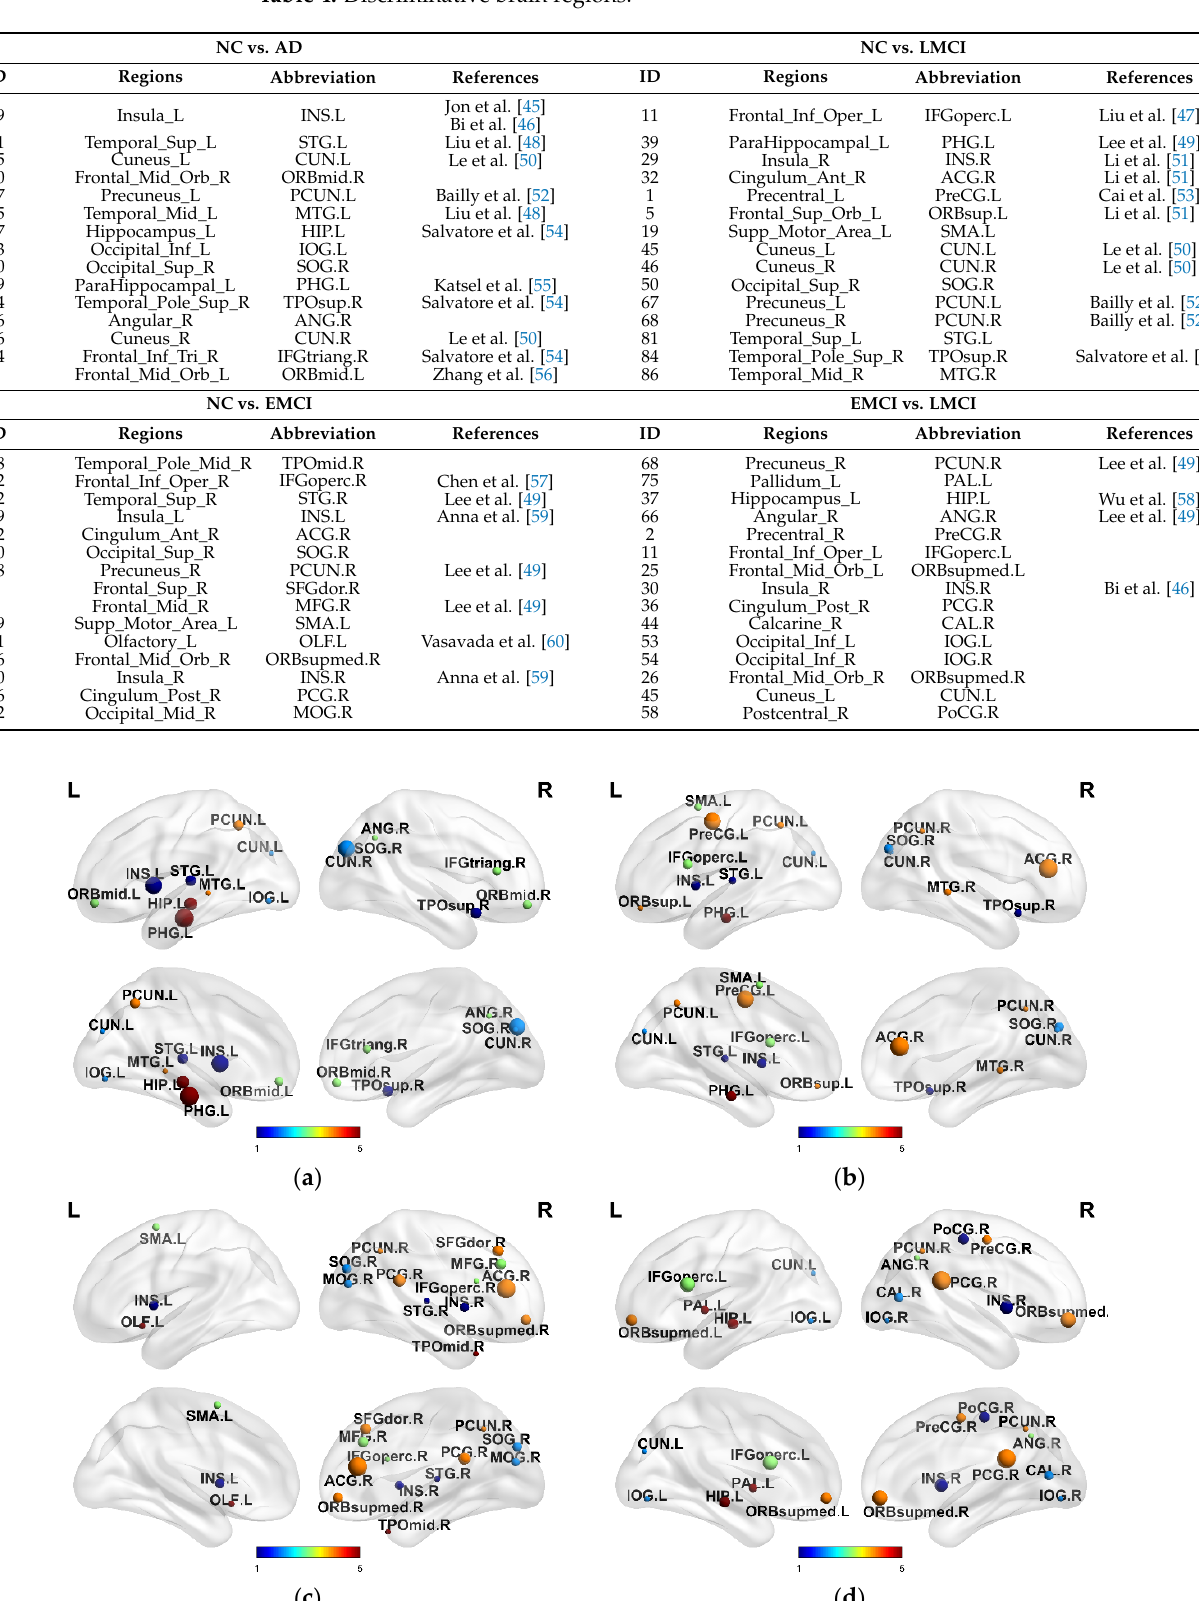
Table 4. Discriminative brain regions.